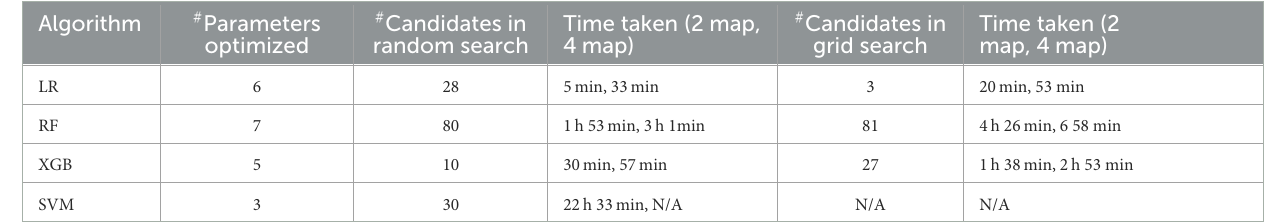
TABLE 2 Details of model training.